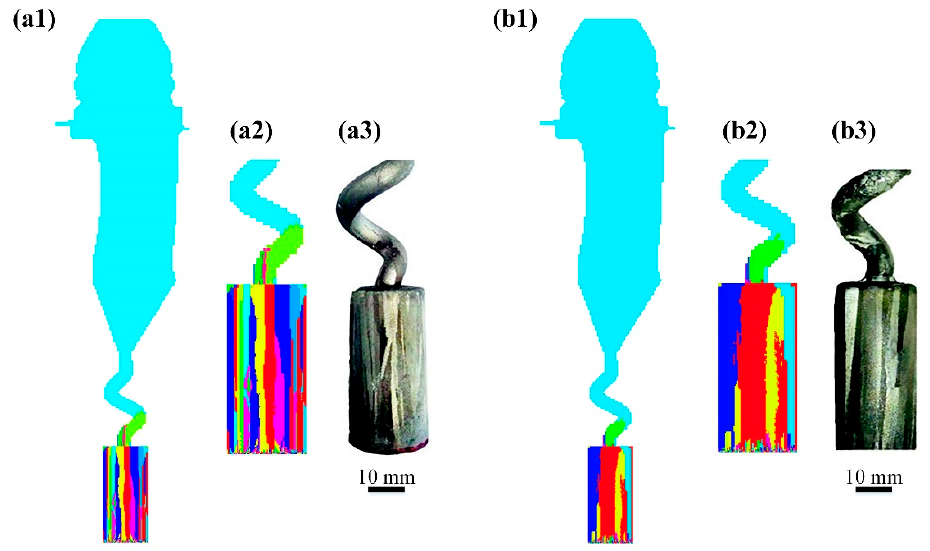
Figure 7. The simulated and experimental results of grain structure in a single crystal blade during HRS ( a1 – a3 ) and LMC ( b1 – b3 ) processes.